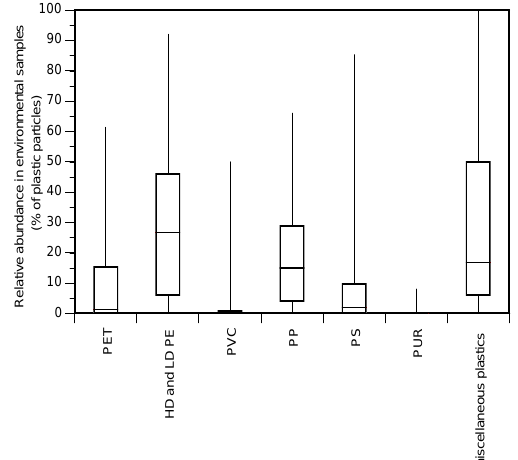
Figure 3. Variation (range (whisker), 25%ile–75%ile (box), and median (horizontal line)) in the relative abundance of polymers (% of particles) identified by studies of microplastics in freshwaters and estuaries.